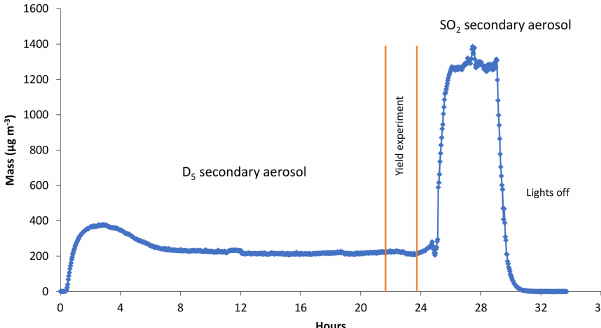
Figure 2. SMPS time series of a typical yield experiment. An equi- libration period was run for ∼ 20h prior to measuring the D 5 gas concentration upstream and downstream of the OFR (yield experi- ment period ∼ 1 . 7h). Aerosol measurements used for yield analysis were from the yield experiment period. After the yield experiment period, the precursor gas was switched to SO 2 for OH quantifica- tion. An SO 2 monitor was used to measure SO 2 downstream of the chamber with and without the OFR lights